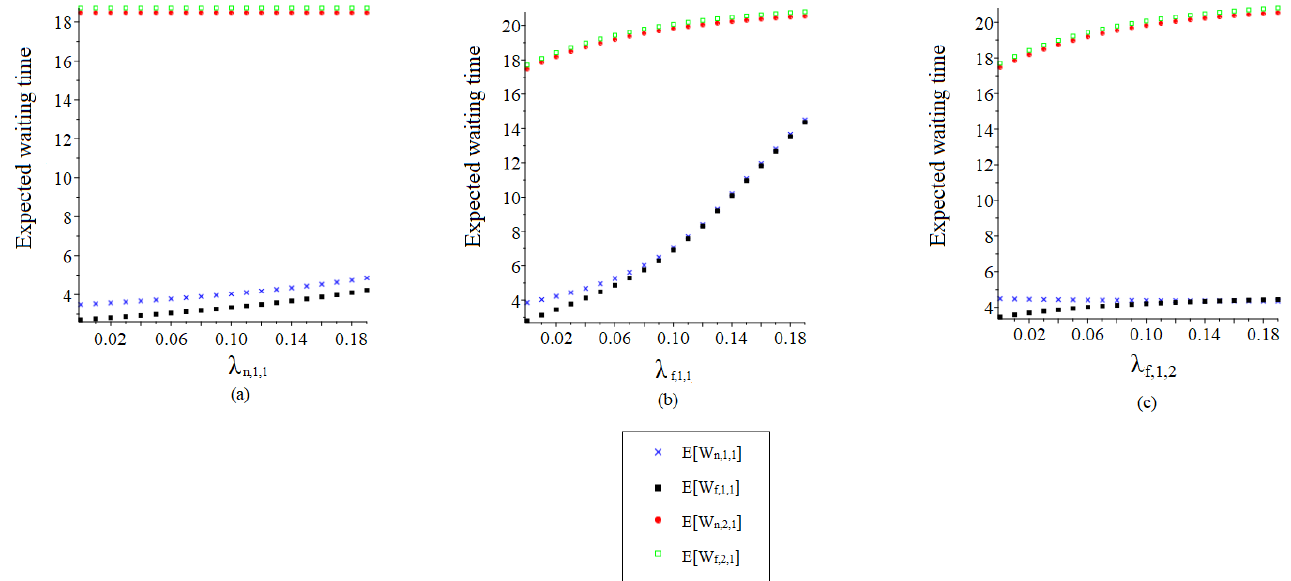
Figure 4. Expected waiting times of vehicles in lanes 1 as functions of ( a ) arrival rates of regular vehicles on the main road, ( b ) freight vehicles on the main road and ( c ) freight vehicles on the main road from the opposite